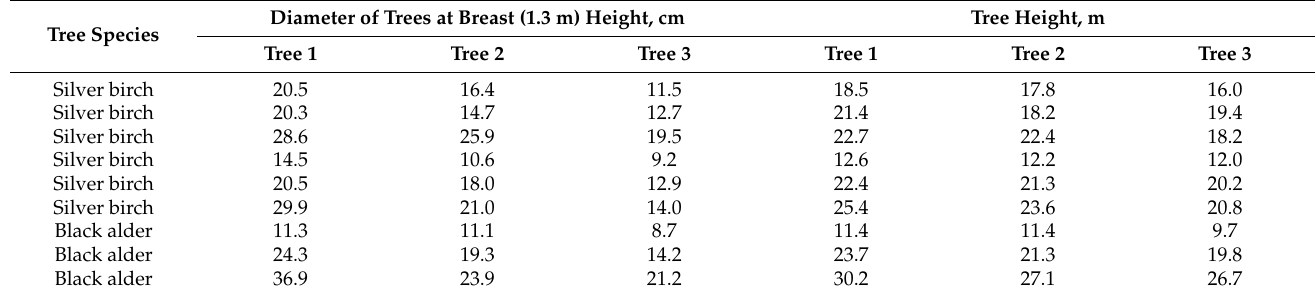
Table 2. Characteristics of individual trees of the studied forest stands.